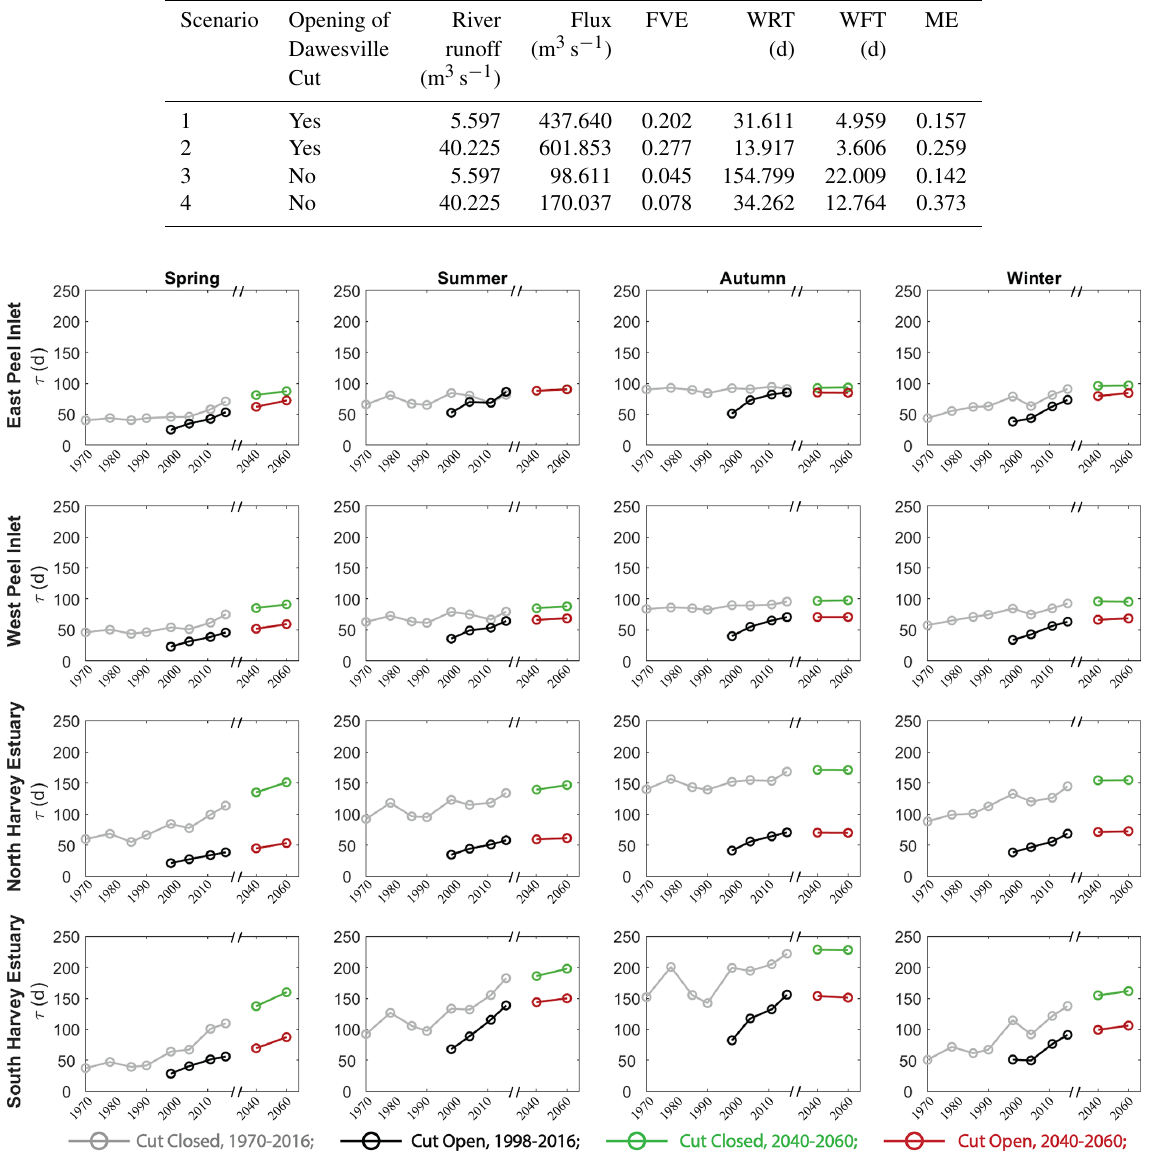
Table 5. Model simulation results for the average water flux through the channels (Flux), fraction of lagoon volume exchanged daily with the ocean (FVE), WRT, WFT and ME in selected scenarios.